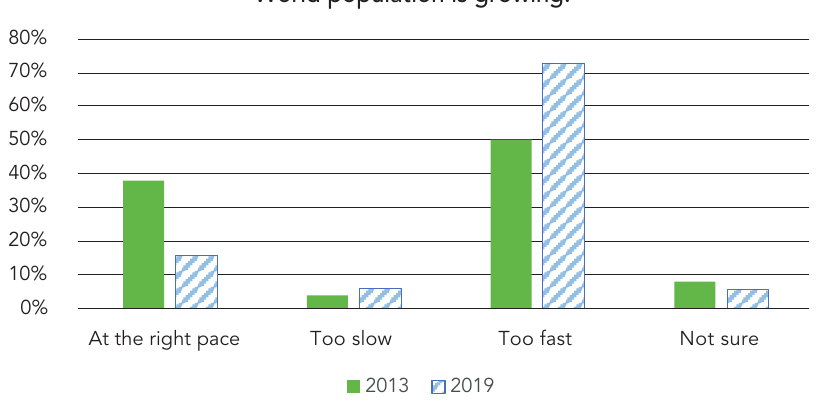
At the right pace Too slow Too fast Not sure